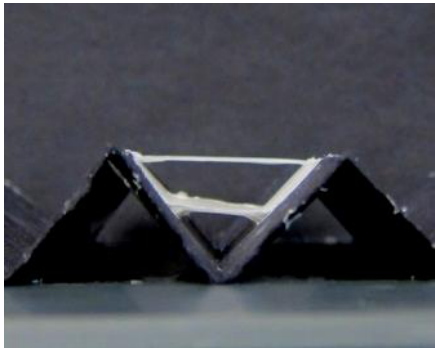
Figure 9. Photographic image showing two nanofiber bridges between the two sides of the V-shaped substrate (variation C).